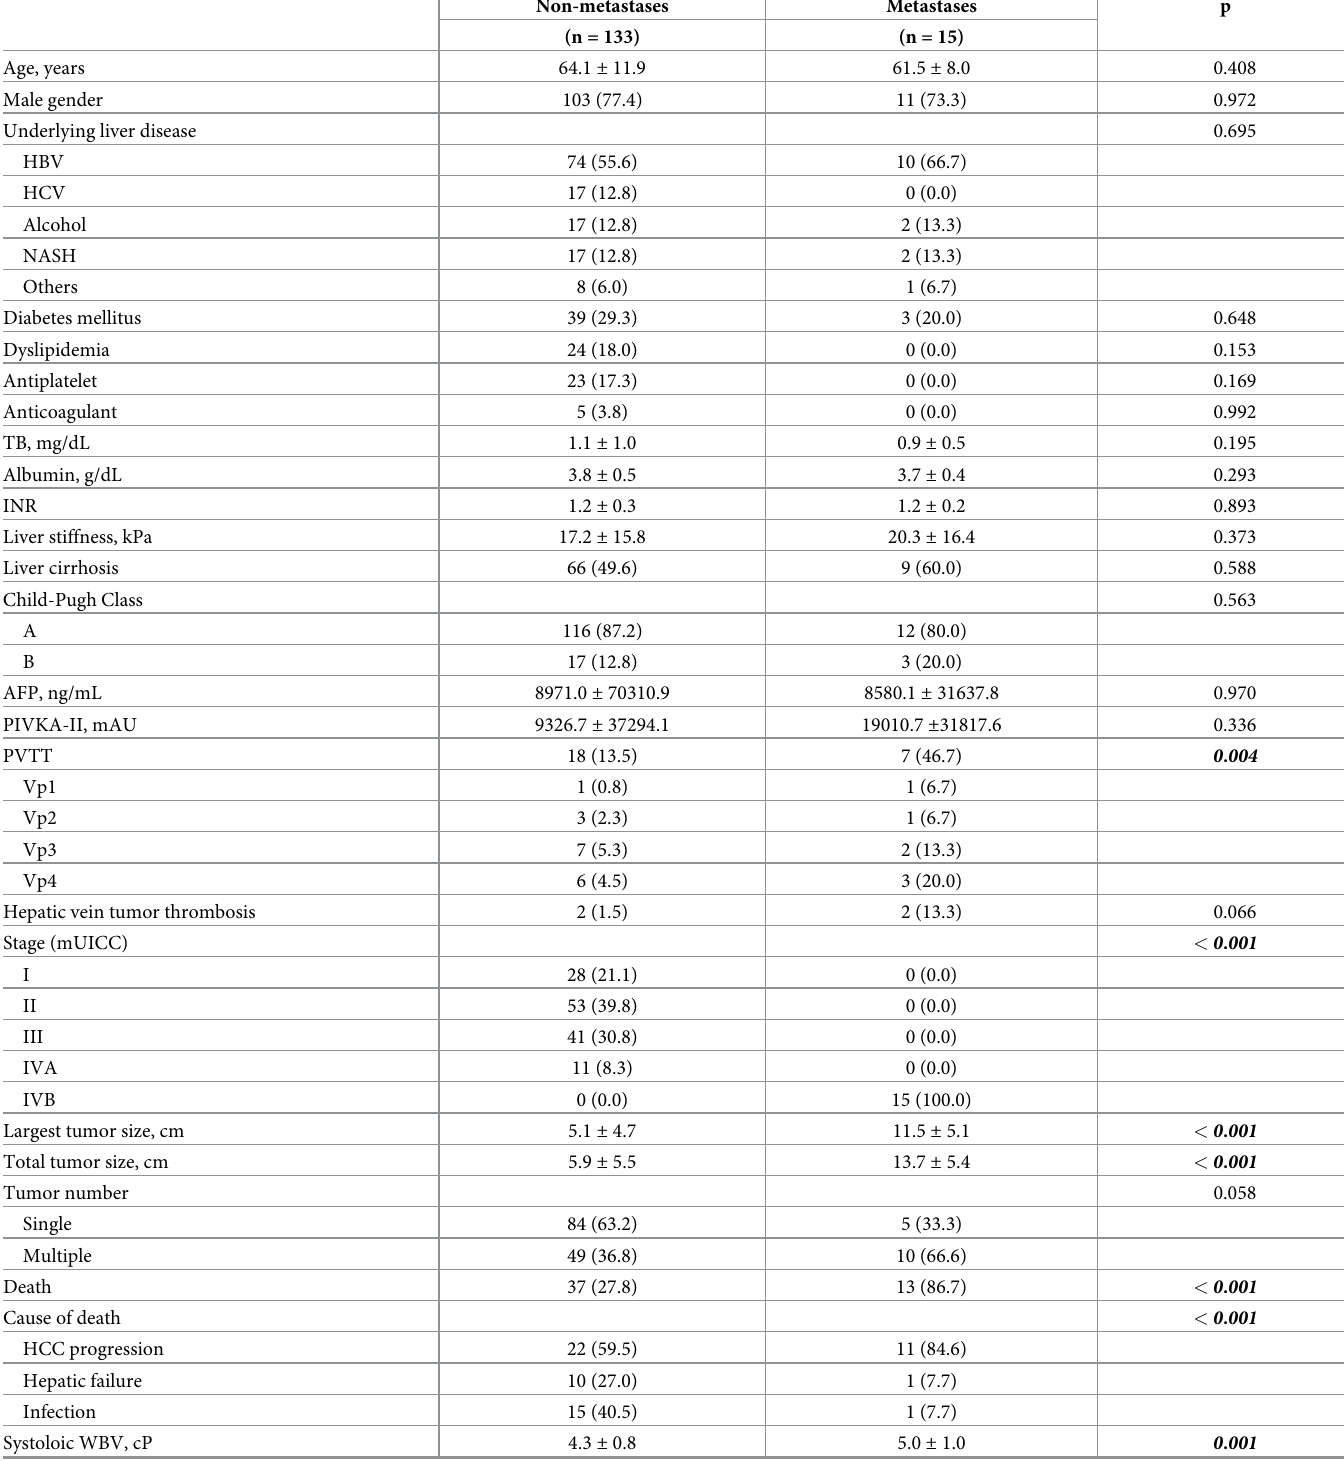
Table 1. Baseline characteristics of HCC patients with extrahepatic metastases and without